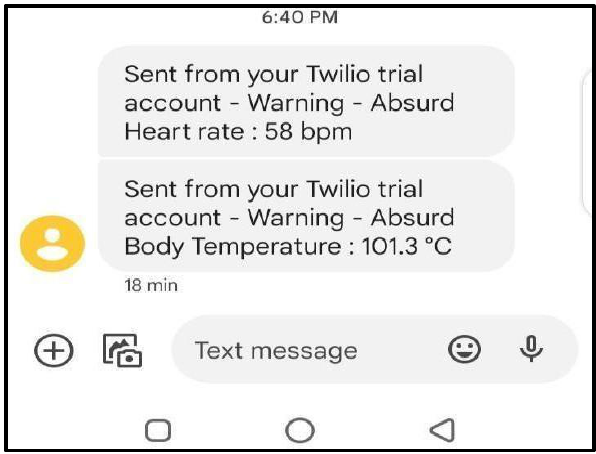
Figure 5. Alert Generate SMS.